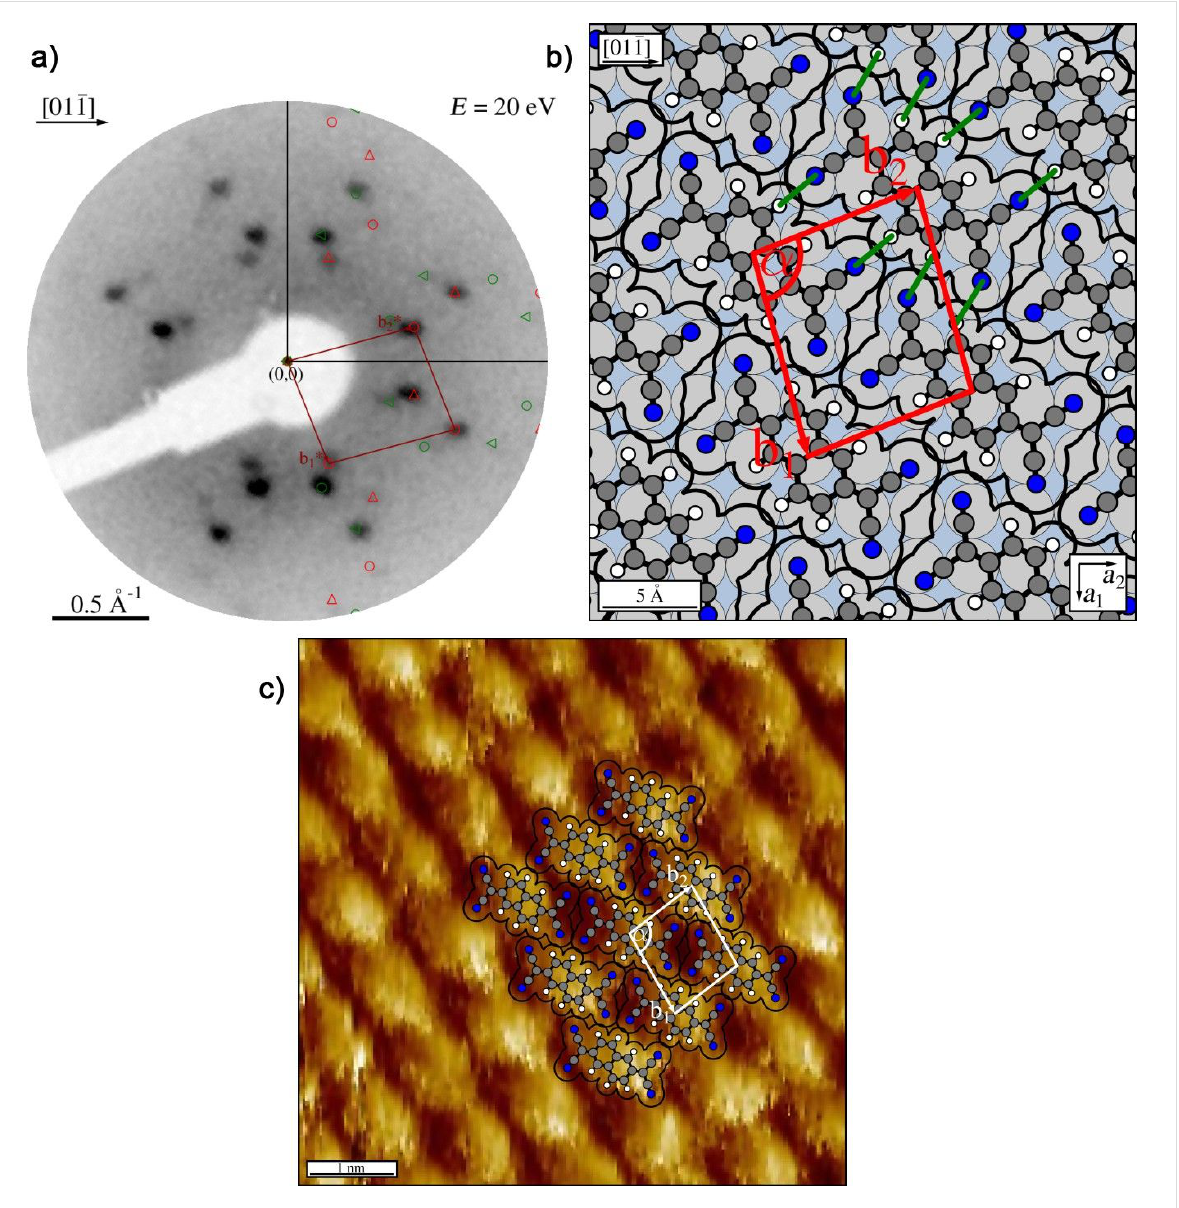
Figure 4: TNAP on Ag(100). (a) LEED pattern an electron energy of 20 eV. A simulated diffraction pattern is overlaid. Symmetry-equivalent domains are marked as in Figure 2. (b) Hard-sphere model with indicated suspected intermolecular hydrogen bonds (green lines). (c) Drift-corrected and filtered STM image. The fast scanning direction is the vertical direction ( U b = − 0.81 V; I t = 127 pA). A hard-sphere model of the structure derived from LEED has been overlaid. The non-symmetric shape of the molecule is assigned to tip effects, but not to a non-planar orientation of the